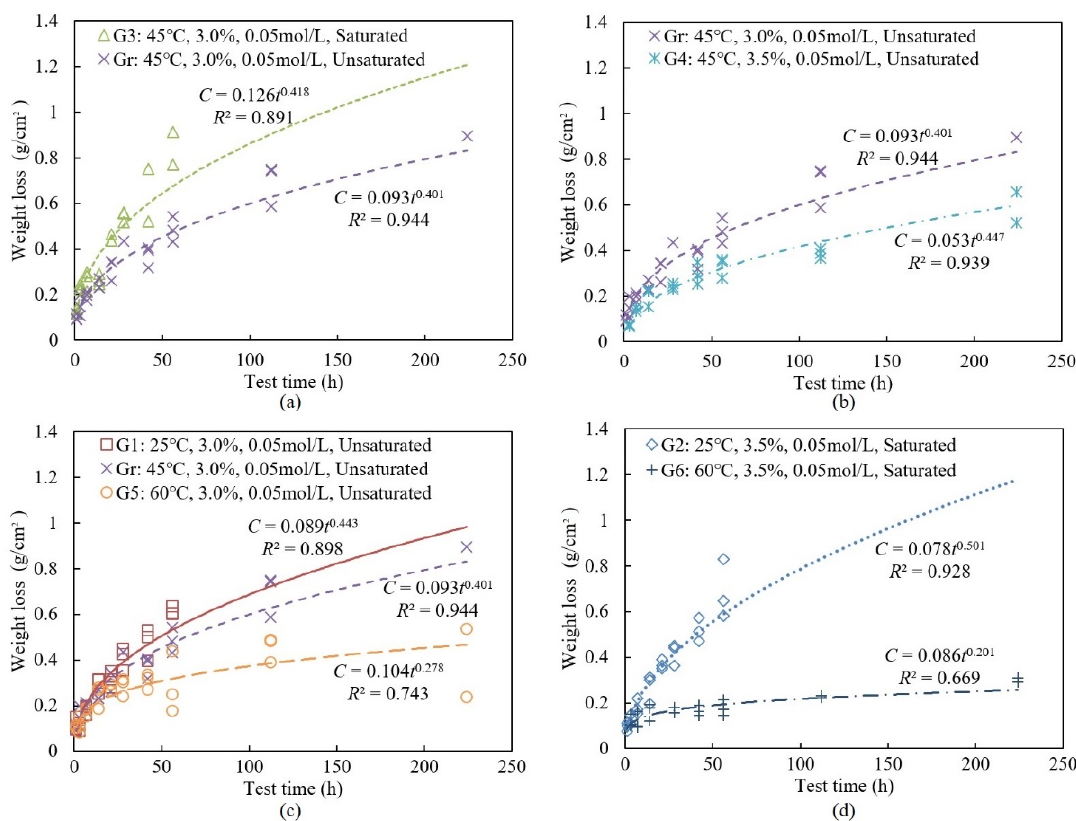
Figure 12. Metal weight loss as a function of test time in seawater under different test conditions: ( a ) saturated and unsaturated dissolved oxygen; ( b ) different salinity; ( c ) and ( d ) different temperature.